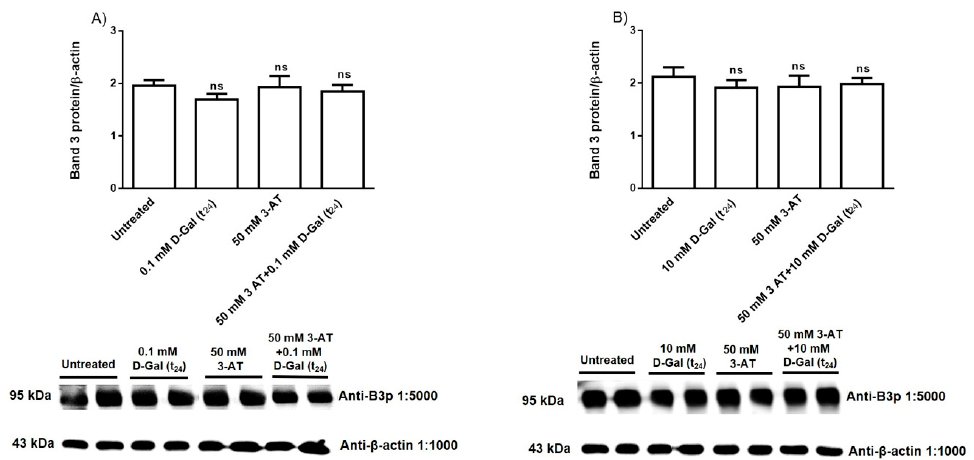
Figure 6. Band 3 protein expression levels measured in untreated (control) and in 0.1 ( A ) or 10 mM ( B ) D -Gal (t 24 )-treated erythrocytes, with or without 50 mM 3-AT pre-incubation, detected by Western blot analysis. ns, not significant versus untreated (control), as determined by one-way ANOVA followed by Bonferroni’s post hoc test ( n = 5).